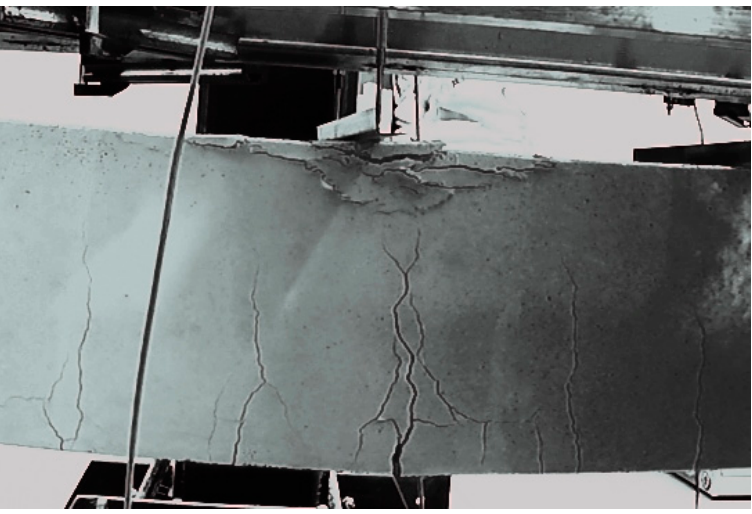
Figure 12. The cracking pattern at the midspan of the RC beam without polyurea coating. In the case of the polyurea-coated RC beams (specimens P.2.1 to P.2.3), the largest cracks were observed at the beam midspan. The polyurea coating efficiently covered the surface cracking to the extent that only wide cracks could be seen. The crack bridging by the coating generated a difference in the visual perception of the crack pattern on elements covered with polyurea coating in relation to uncoated beams (Figures 12 and 13) because, in this case, smaller scratches were not noticeable to the naked eye. During the tests, it was found that the polyurea coating covered cracks of up to 5 mm in width in the cracked cross-sections. In this case, the concrete cracking state should not accelerate, eventually reaching the serviceability limit state as there are no open cracks on the surface of the beams. The polyurea coating efficiently covers cracks and protects the element against penetration by corrosive fluids (water, air, and chemical compounds). The cracking on the surface of the coated RC beam is shown in Figure